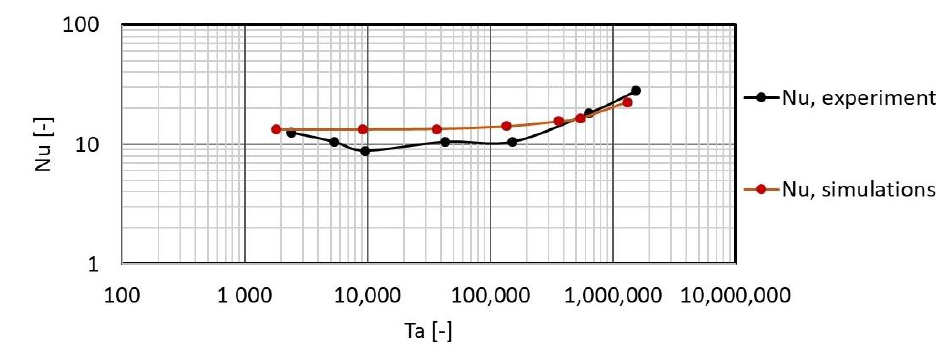
Table 7. Defined adequate numerical set-ups for the considered flow cases from Lee [6].